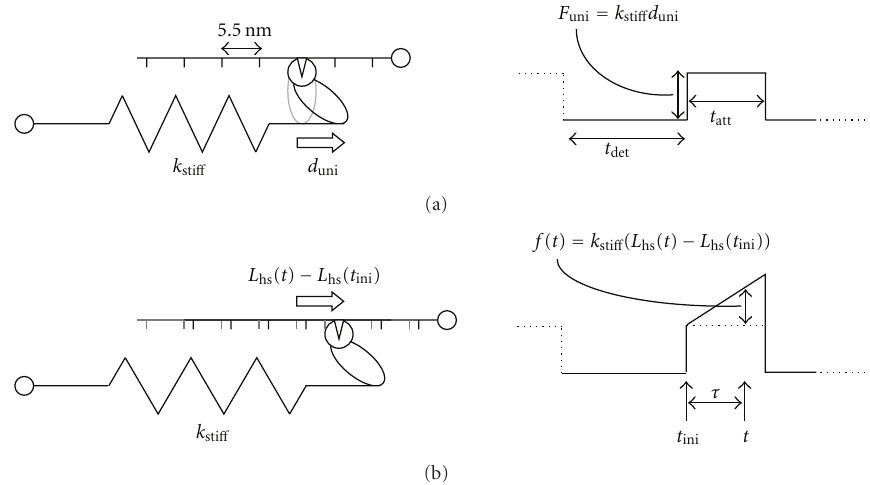
Figure 1: Force due to myosin crossbridges. (a) A unitary force, F uni , is generated over a finite time of attachment, t att (also called time-on), when the myosin power stroke swings the lever arm a net unitary displacement, d uni . The time of detachment, t det , refers to the time period between a crossbridge detaching from actin and before reattaching. (b) An additional crossbridge-dependent force is transmitted through the half sarcomere when an elastic element in series with the crossbridge and with sti ff ness k sti ff undergoes a length change due to an externally applied perturbation of the half sarcomere, L hs . The force recorded at any time t , f ( t ), due to the perturbation reflects the displacement of the elastic element since the initial time of crossbridge attachment, t ini